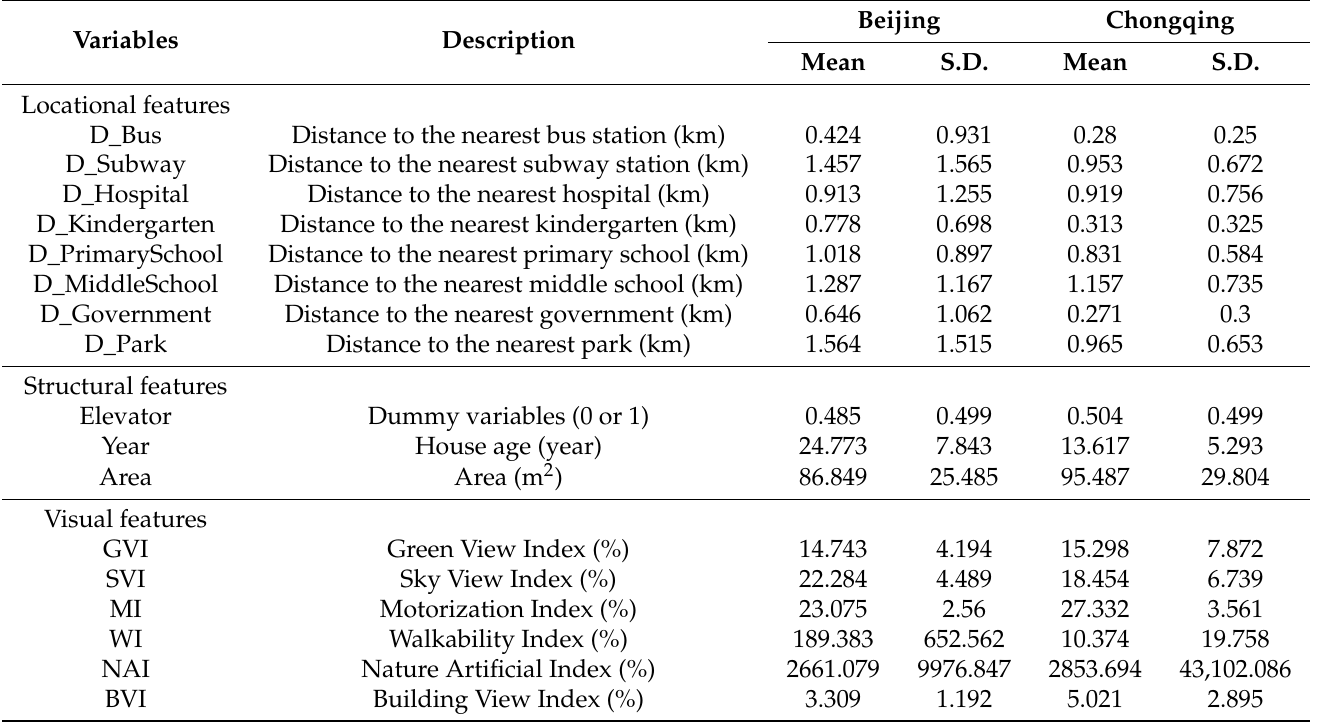
Table 3. Variables descriptive